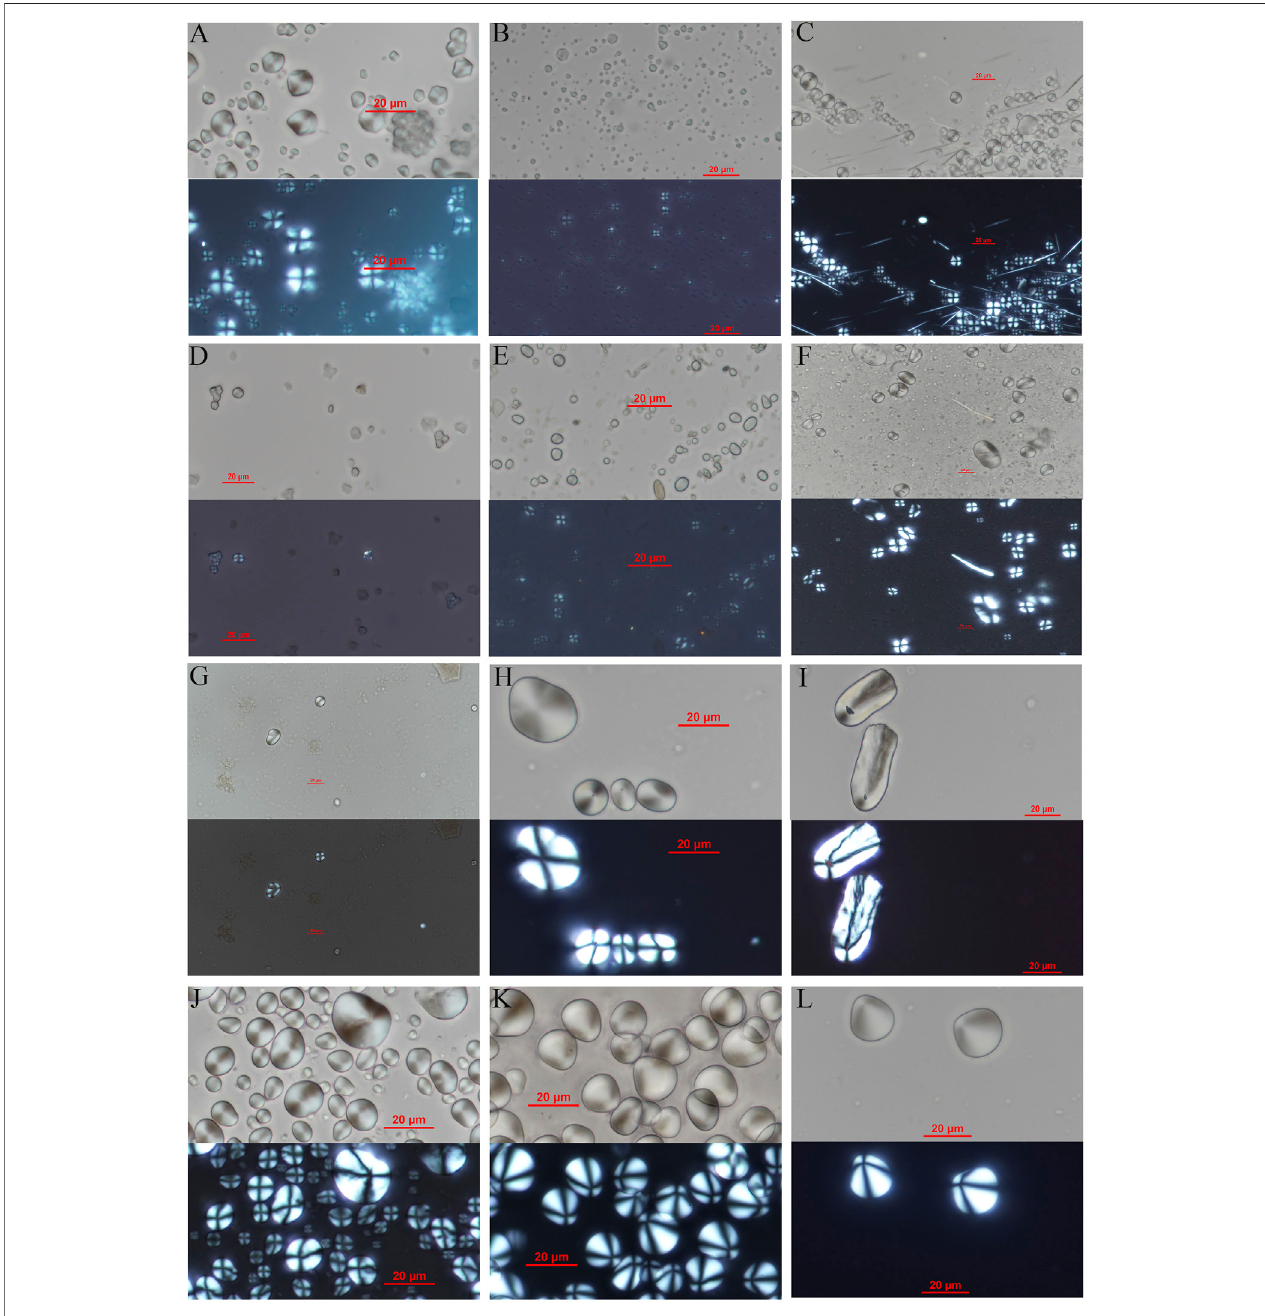
FIGURE3| Modernplantstarchreferencesincludedinthispaper. (A) Puerarialobata (B) Amorphophallusvirosus (C) Pinelliaternata (D) Zizaniaaquatica (seed) (E) Acorus tatarinowii (F) Canavalia gladiata (G) Vigna umbellata (H) Trapa bispinosa (I) Nelumbo nucifera (root) (J) Sagittaria trifolia (K) Bolbostemma paniculatum (L) : Polygonatum sibiricum